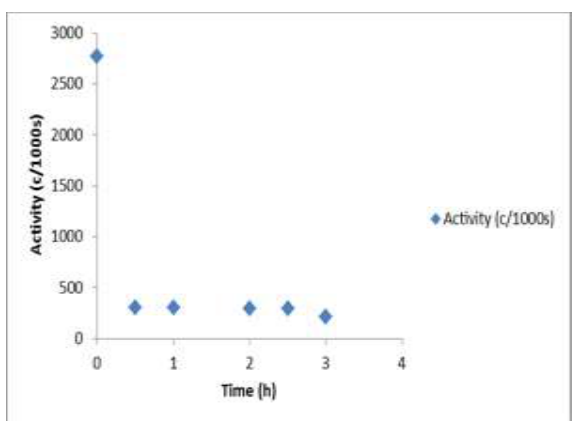
Fig.3: Effect of contact time on the removing of cesium from the solution .